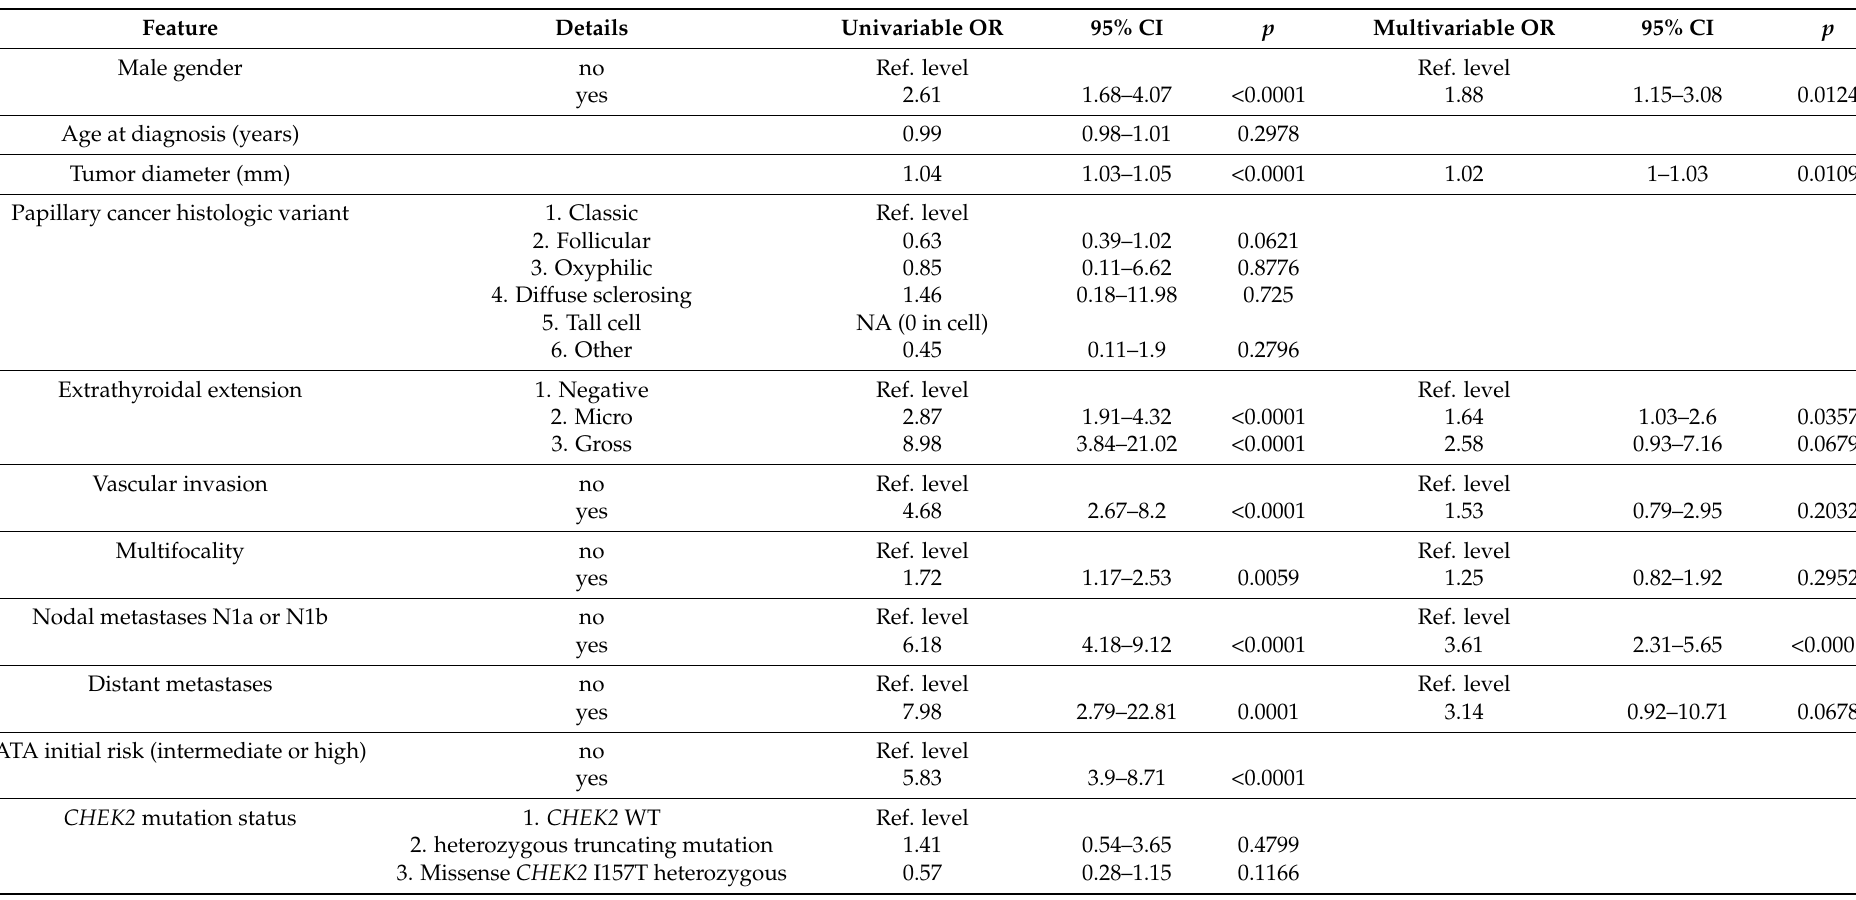
Table 6. Risk factors for patients without remission (indeterminate, biochemically and structurally persistent disease) in final